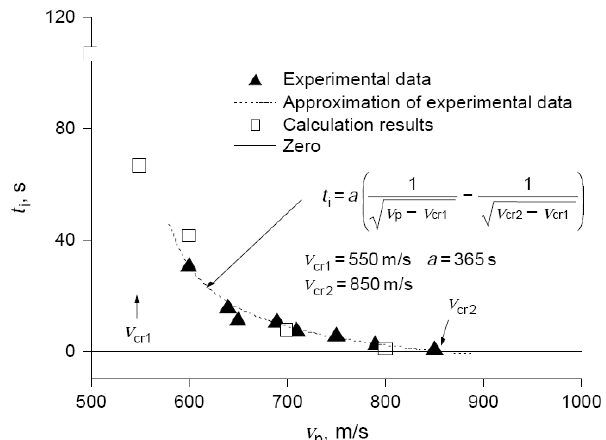
Figure 7: Induction (deposition delay) time vs. the mean impact velocity of Al particles on a polished Cu substrate [7]. Splat